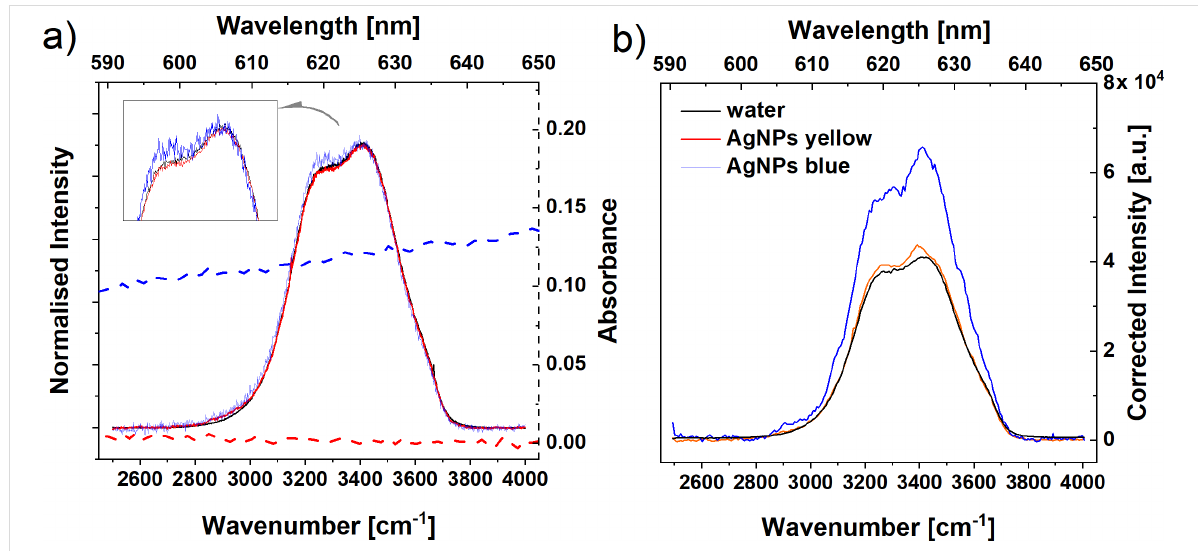
Figure 3: (a) Normalised Raman spectra in the OH stretching vibration region for pure water and two AgNPs dispersions, dotted lines are absorption spectra of AgNPs samples, inset shows a spectral region zoomed in on the maxima of the OH stretching vibration band. (b) The same Raman spec- tra after reabsorption correction – figure adapted from